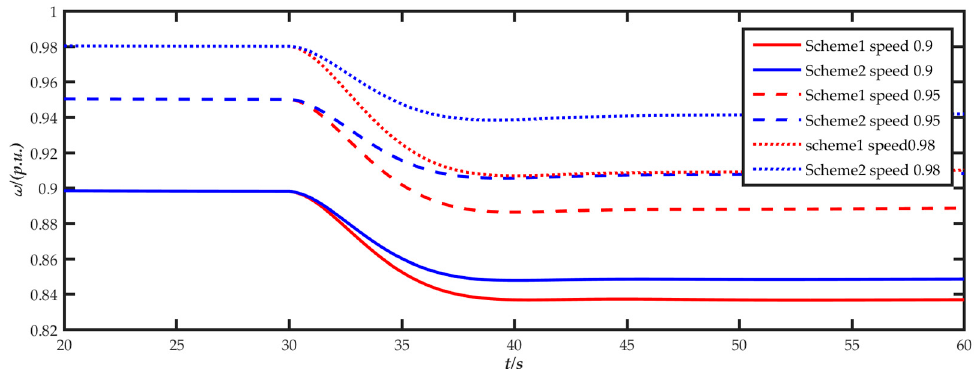
Figure 11. Speed change in wind turbines in the medium-wind speed zone.